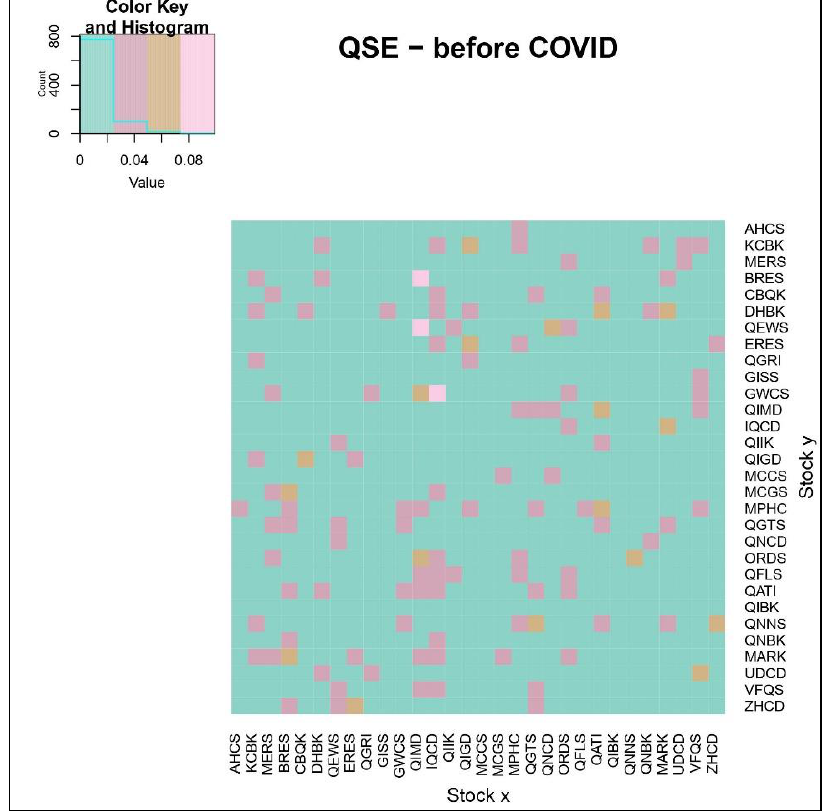
Figure 15. The information flow (effective transfer entropy) from stock y to stock x, for the top companies (by market capitalization) in the QSE market, before the COVID-19 outbreak